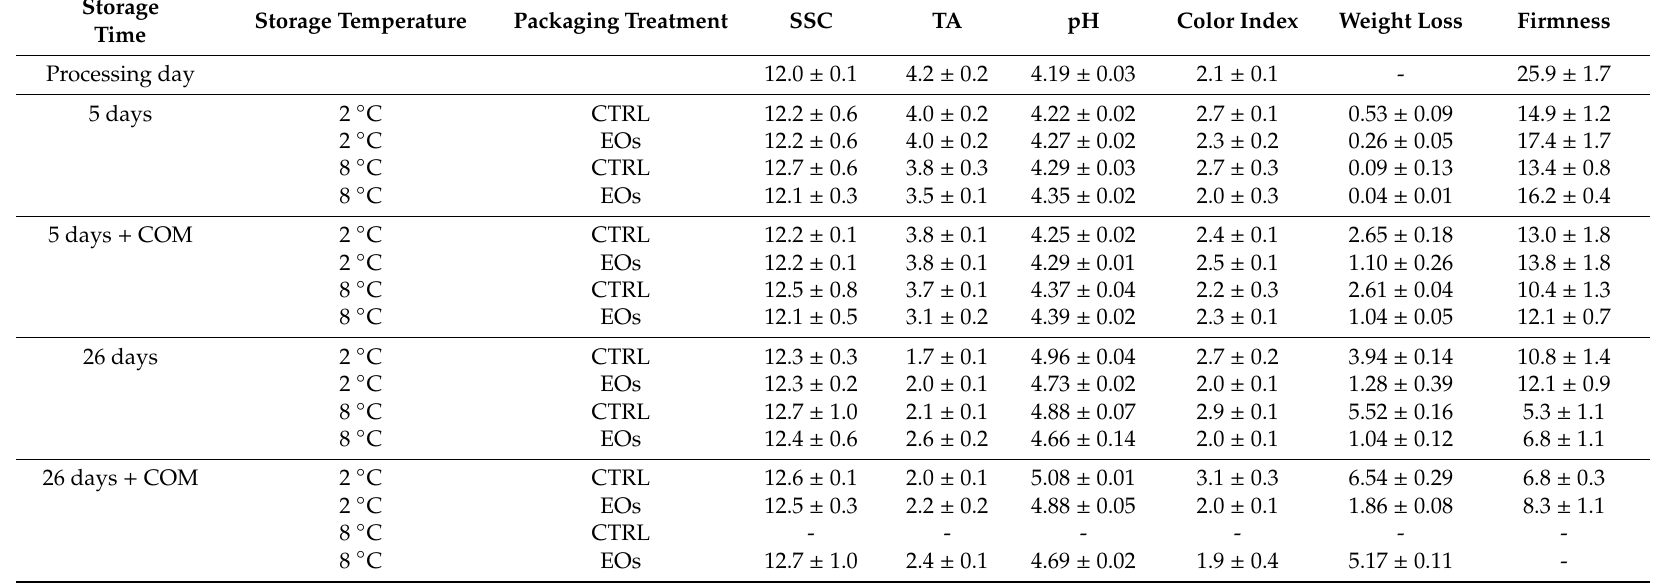
Table 2. Soluble solids content (SSC; ◦ Brix), titratable acidity (TA; %), pH, color index, weight loss (%), and firmness (N) values during cold storage periods (2 and 8 ◦ C) and complimentary commercialization simulations (COM; 4 days at 22 ◦ C) for flat peaches with or without active paper sheets (including β CD-encapsulated EOs) ( n = 3 ±